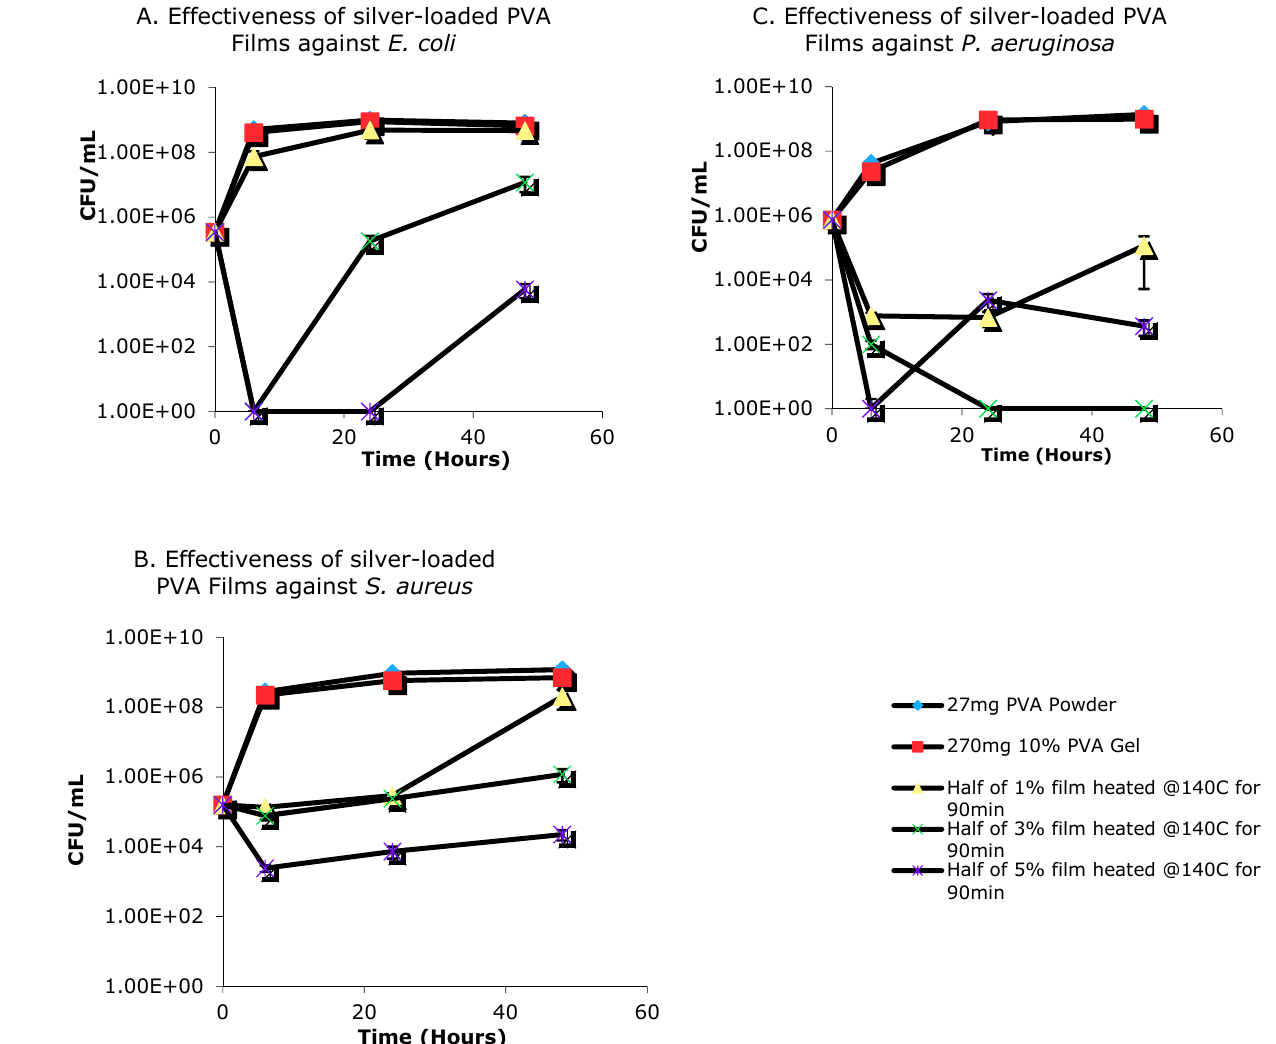
Figure 11. Evaluation of in vitro antimicrobial activity of PVA-silver films against ( A ) E. coli ; ( B ) S. Aureus and ( C ) P. Aeruginosa.